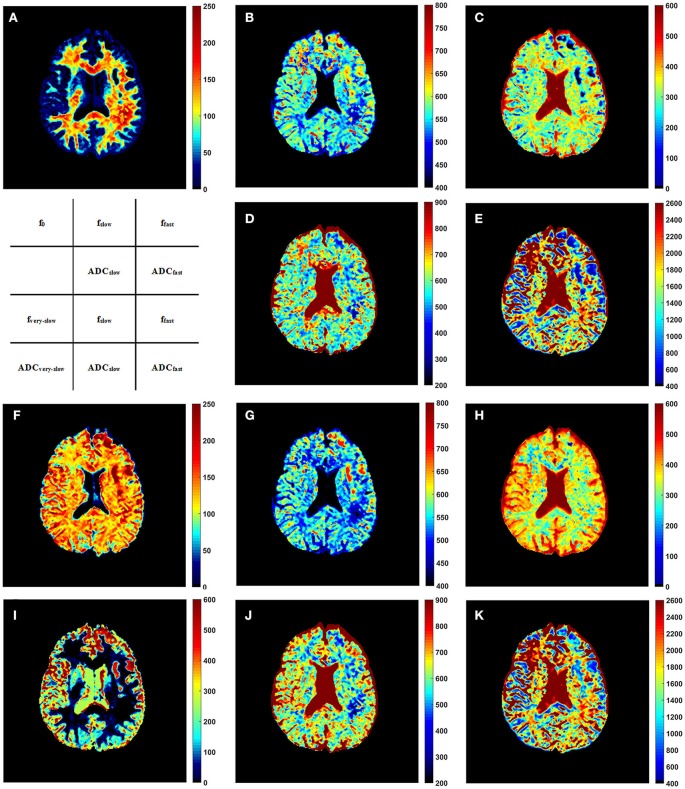
The f0 map (A), fslow map (B), ffast map (C), ADCslow map (D), and ADCfast map (E) derived from the modified tri-exponential model. The fvery−slow map (F), fslow map (G), ffast map (H), ADCvery−slow map (I), ADCslow map (J), and ADCfast map (K) derived from the conventional tri-exponential model. The unit for f maps is ‰, and the unit for ADC maps is ×10−6 mm2/s.